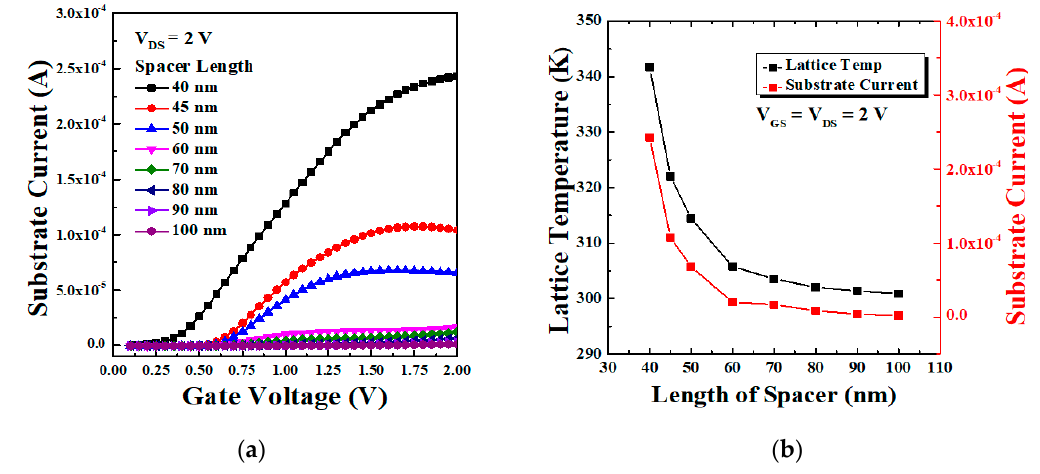
Figure 4. ( a ) Substrate current versus gate voltage characteristics; and ( b ) comparison of substrate current and lattice temperature of N-type bulk FinFET according to spacer length.